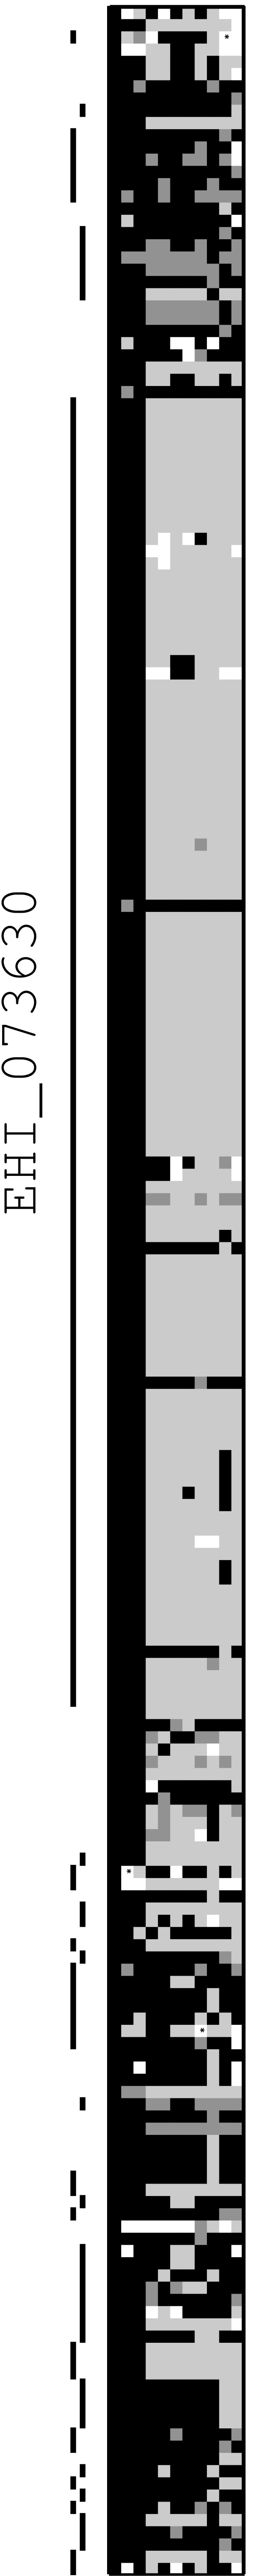
The pattern of polymorphism across scaffold DS571171. Polymorphic sites on scaffold DS571171 are represented by shaded squares: black for bases that match the HM-1:IMSS reference; light grey for bases that differ from the reference; dark grey for heterozygous positions; white for positions where no base was assigned. Three positions (marked with asterisks) had an additional variant base in one strain. Each row represents a strain in the following order from top to bottom: reference sequence (HM-1:IMSS), HM-1A, HM-1B, Rahman, 2592100, PVBM08B, PVBM08F, IULA:1092:1, HK-9, MS84-1373, MS27-5030. Sites in coding sequences are marked with black lines above the figure.